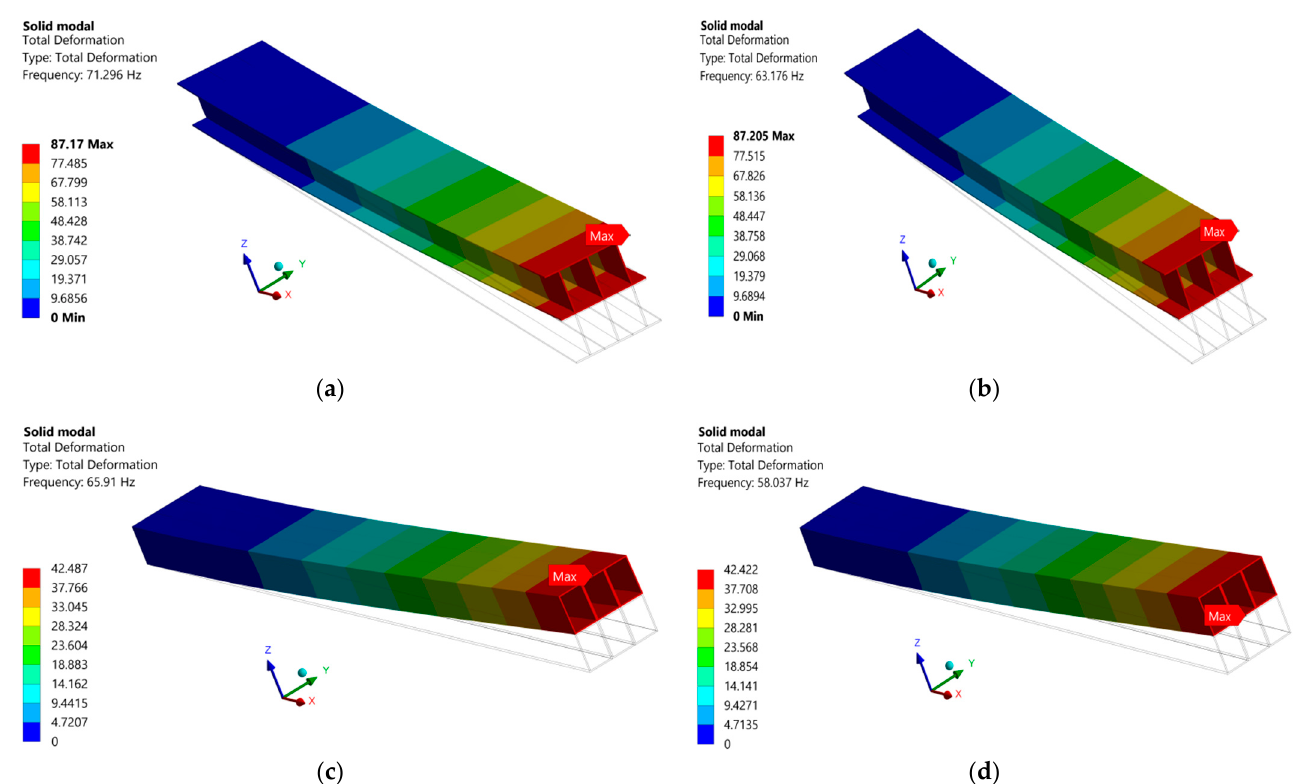
Figure A5. Natural mode shapes of the CFRP cantilever beam related to Section 7 for ( a ) “III” section and “L2” layup, ( b ) “III” section and “L8” layup, ( c ) “SSS” section and “L2” layup, and ( d ) “SSS” section and “L8” layup.